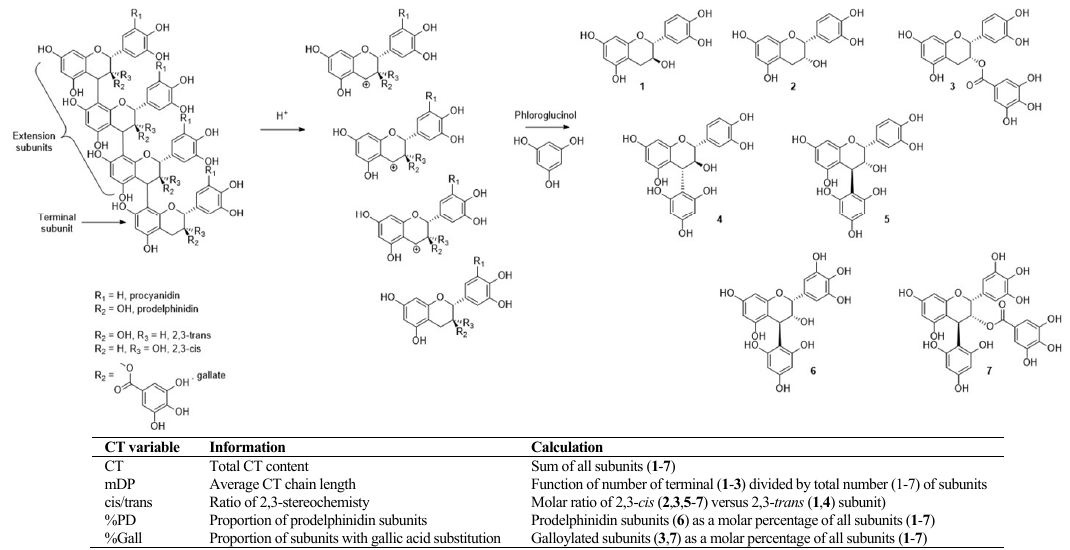
Figure 1. Acid-catalyzed depolymerization of a condensed tannin chain followed by reaction with phloroglucinol to yield identifiable subunits that are found in grape-derived CT, and subunits involved in calculating CT variables from phloroglucinolysis.